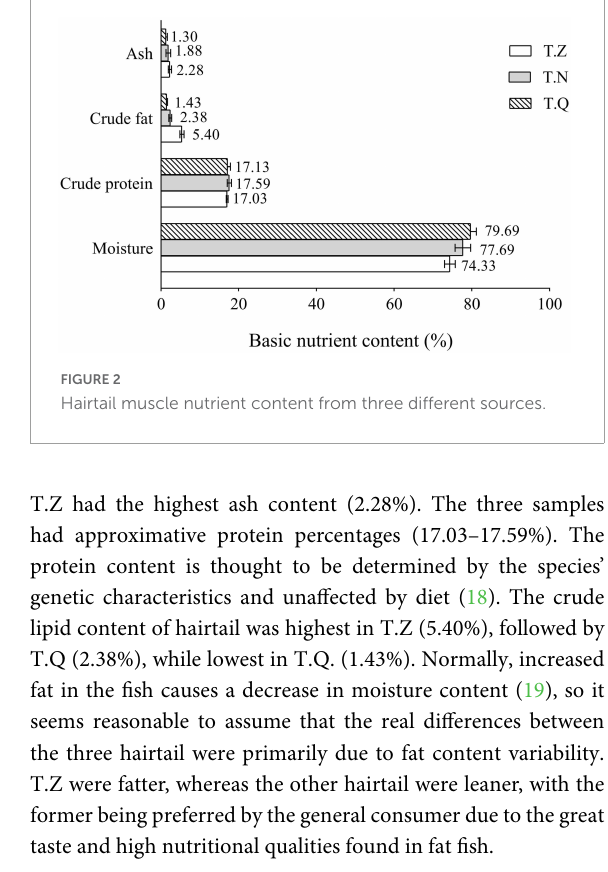
TABLE 2 Texture profile analysis of three type hairtail.